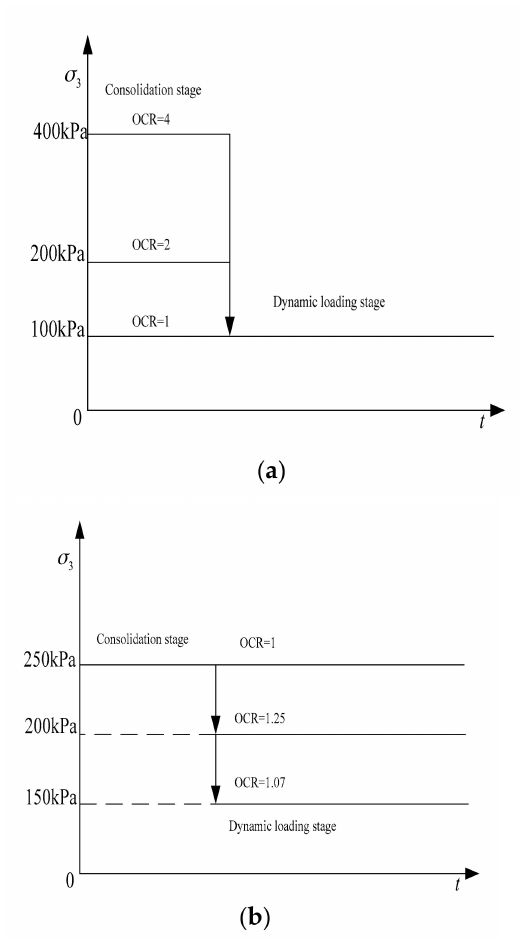
Figure 11. p (cid:48) changes: ( a ) in Sun Lei’s test; ( b ) in this